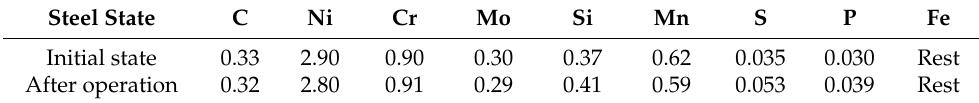
Table 1. Chemical composition of 34KhN3M steel for steam turbine rotor disk, wt. %. Steel State C